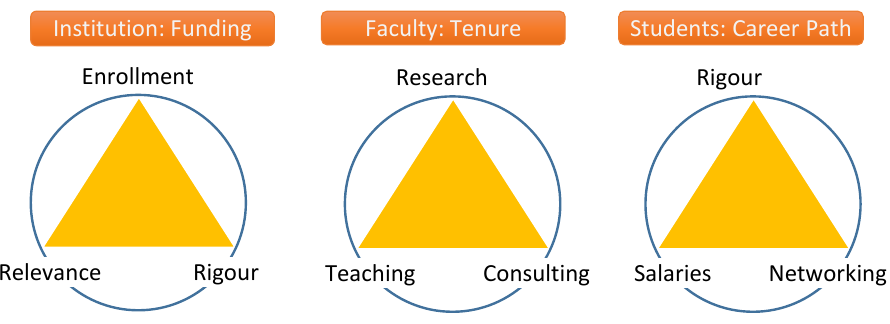
Figure 5. Alignments and tradeoffs in business